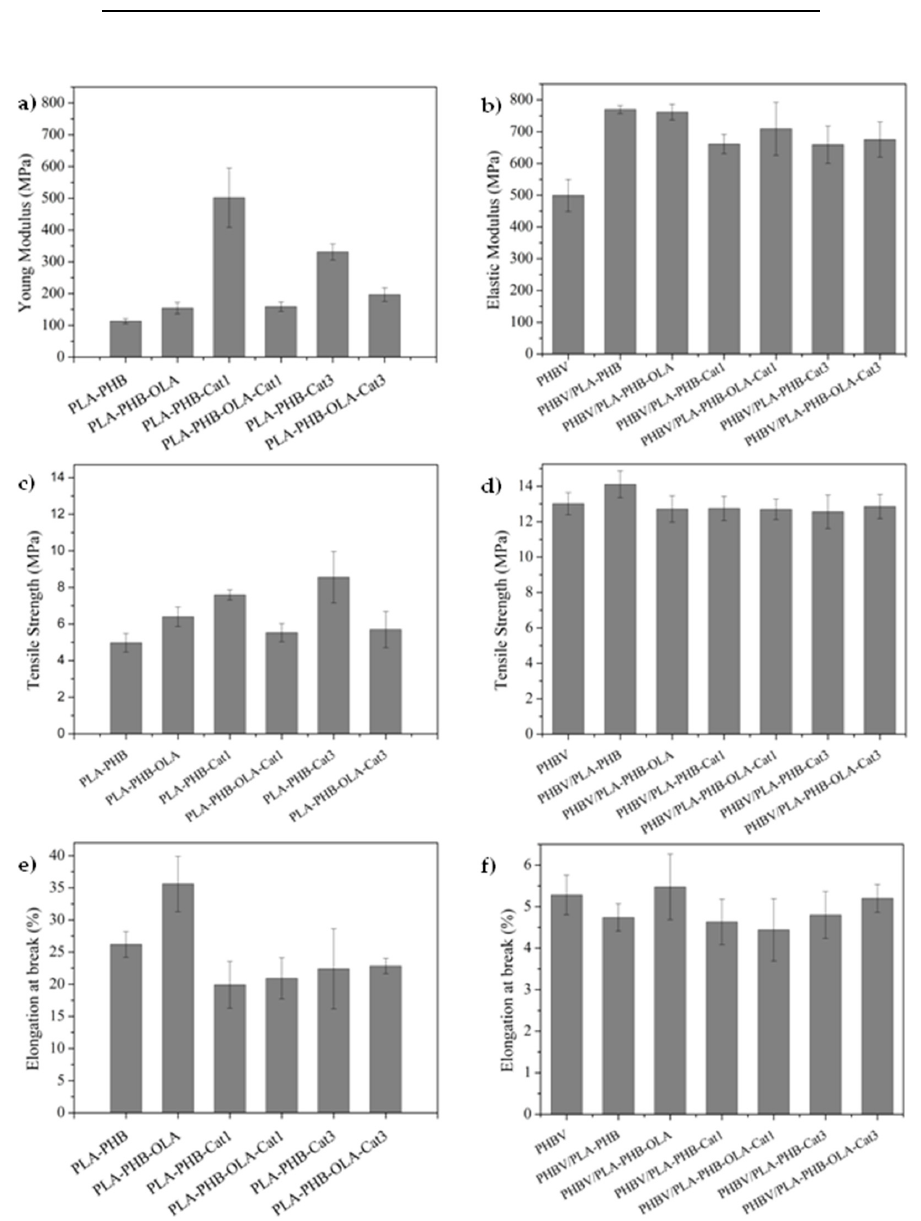
Figure 4. Mechanical properties of electrospun monolayer mats ( left ) and bilayer systems ( right ).